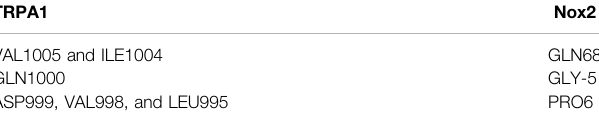
TABLE 3 | The binding sites of Nox2 and TRPA1